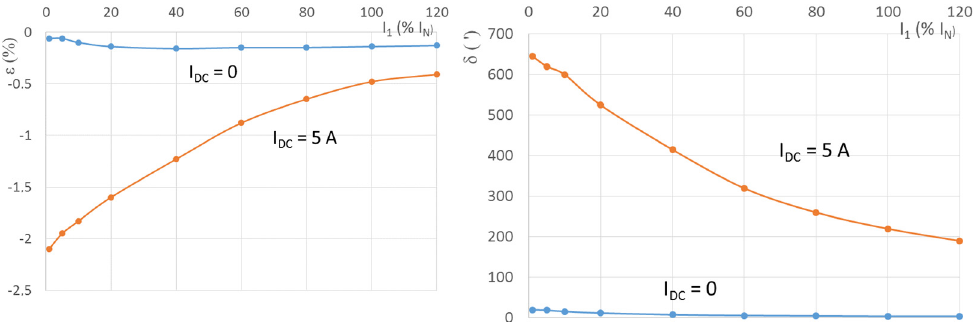
Figure 2. Ratio error ε I and phase error δ I of the 500 A/1 A current transformer CT2 for zero DC current and I DC = 5 A as a function of measured current I 1 .